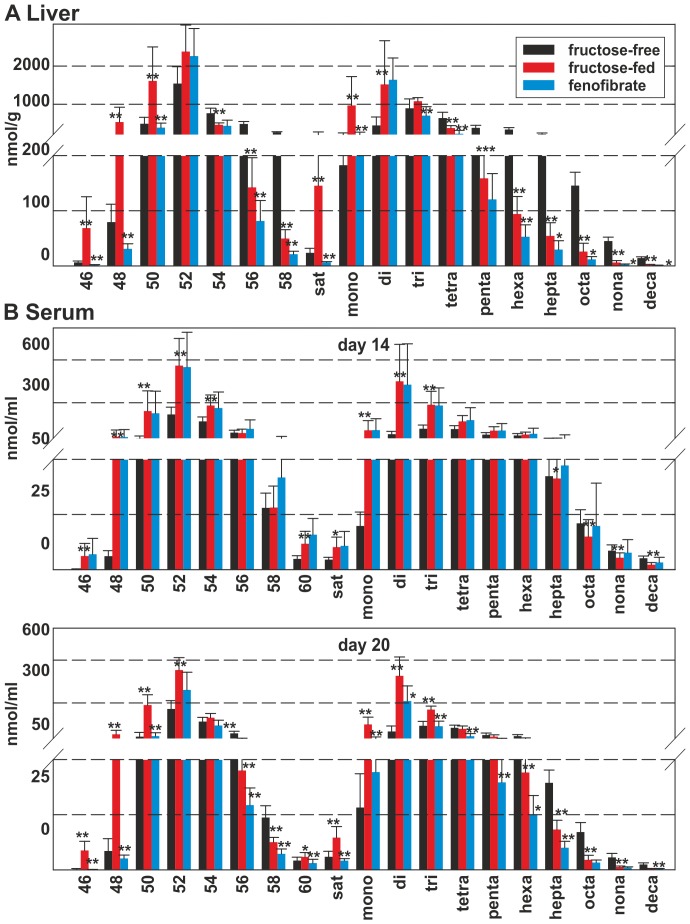
TAG-species in rat liver.Values given are means±s.d. of the sums of the different chain lengths (C46–C60) on the left and degree of desaturation (sat – deca) on the right. Serum data is shown for day 14 and day 20; the control group is shown as black bar, the fructose-fed group is shown as red bar and the FF treated group is shown as a blue bar; significant changes are indicated using *: P<0.05; **: P<0.01; ***: P<0,001.